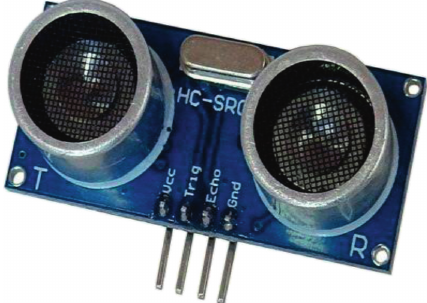
Figure 3: Ultrasonic sensor.